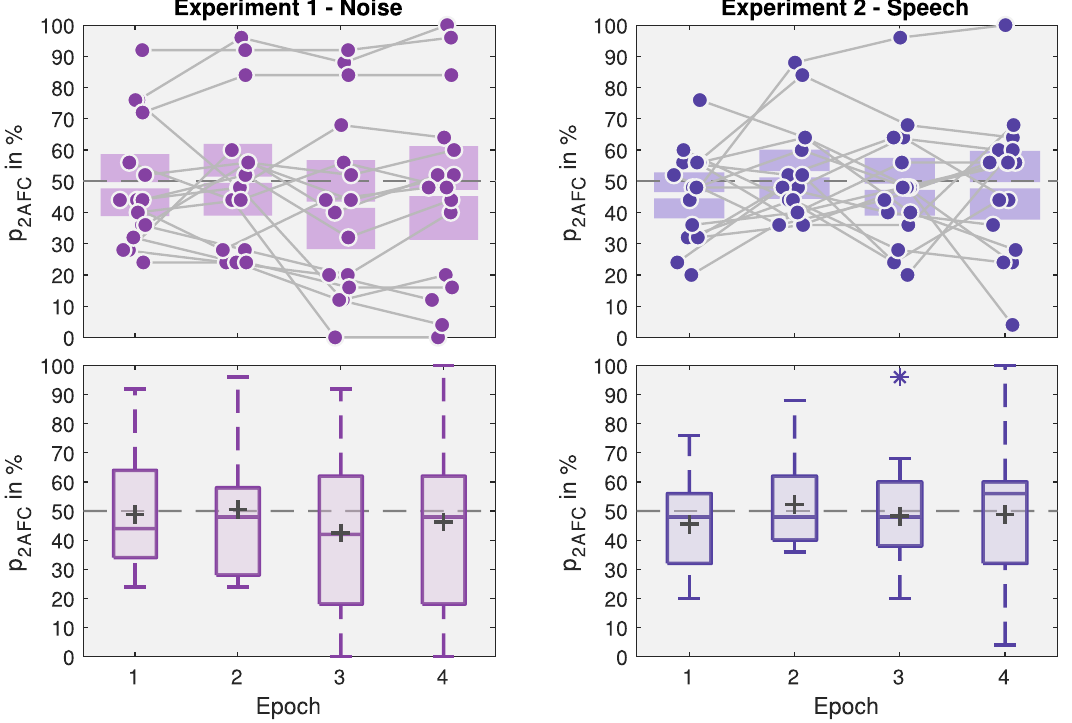
Figure 6. Results of Experiment 1 (left) and Experiment 2 (right) as a function of four epochs with 25 trials each. The top plots show the determined individual p 2 AFC values in each epoch as points (horizontal offset for better readability). Individual data points are connected with gray lines. The boxes show the mean (box notch) and the 95% between-subject CI for each epoch. The gray dashed line denotes 50% chance level. The bottom plots show the interindividual variation in the determined p 2 AFC values for each epoch in the form of a box plot with the median (box line), the mean (cross), and the (across participants) interquartile range (IQR); whiskers display 1.5 (cid:1) IQR below the 25th or above the 75th percentile and outliers beyond that range are indicated by asterisks.